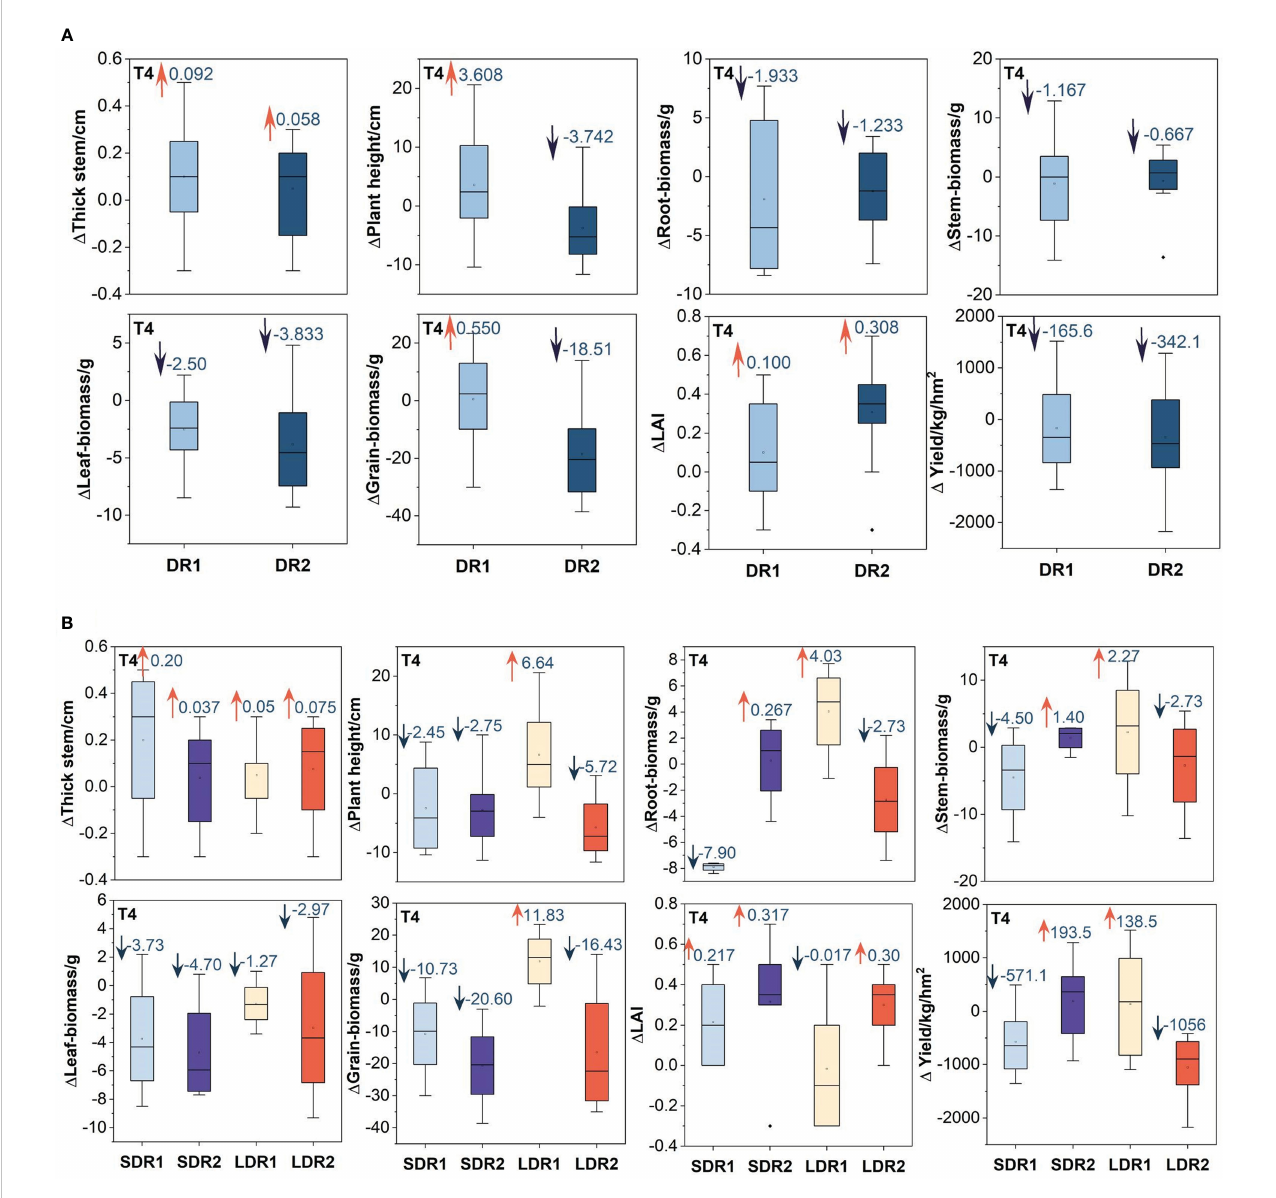
FIGURE 5 The persistent effects of different (A) drought degrees and (B) drought duration on growth indexes of summer maize in the T4